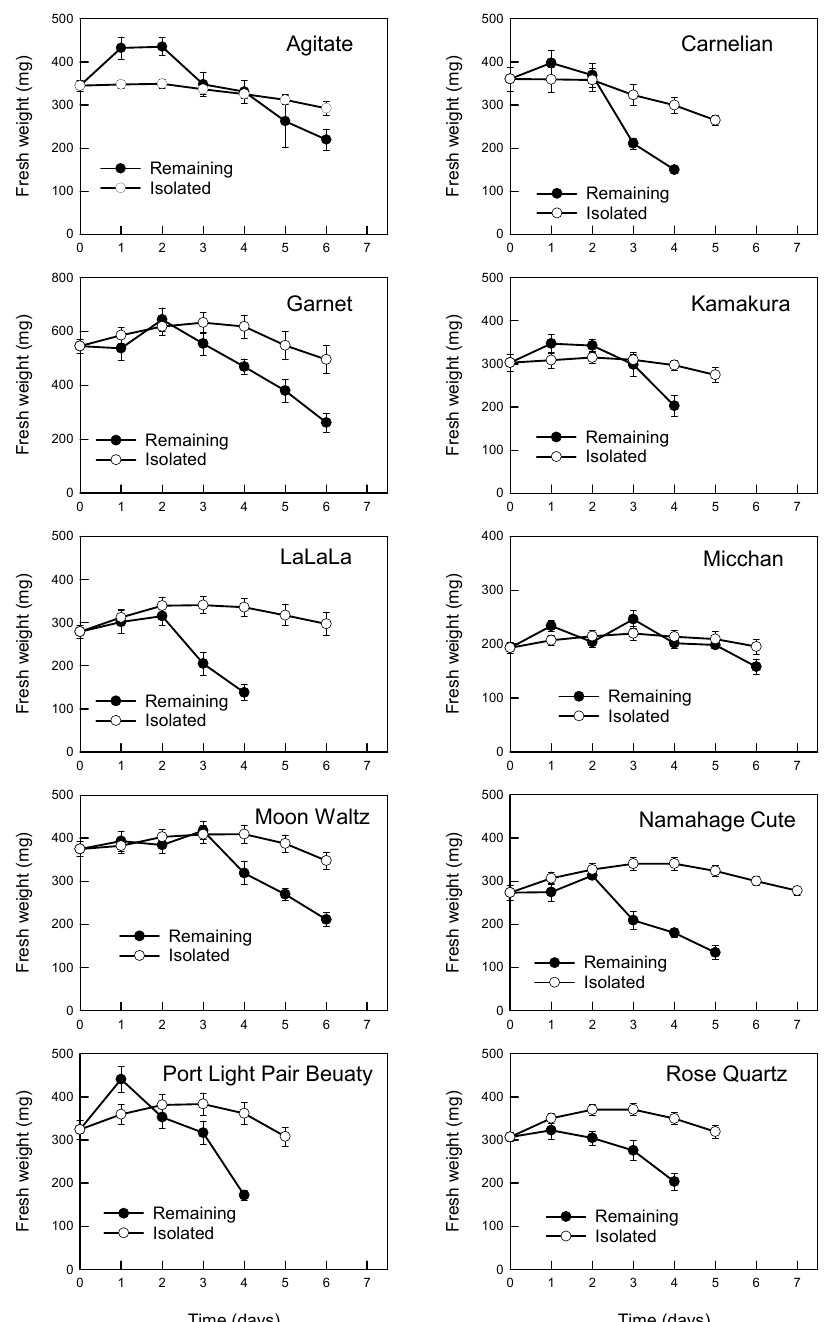
Figure 2. The fresh weight of isolated petals and those remaining in the inflorescence of 10 dahlia cultivars. Values are the means of six replicates ±